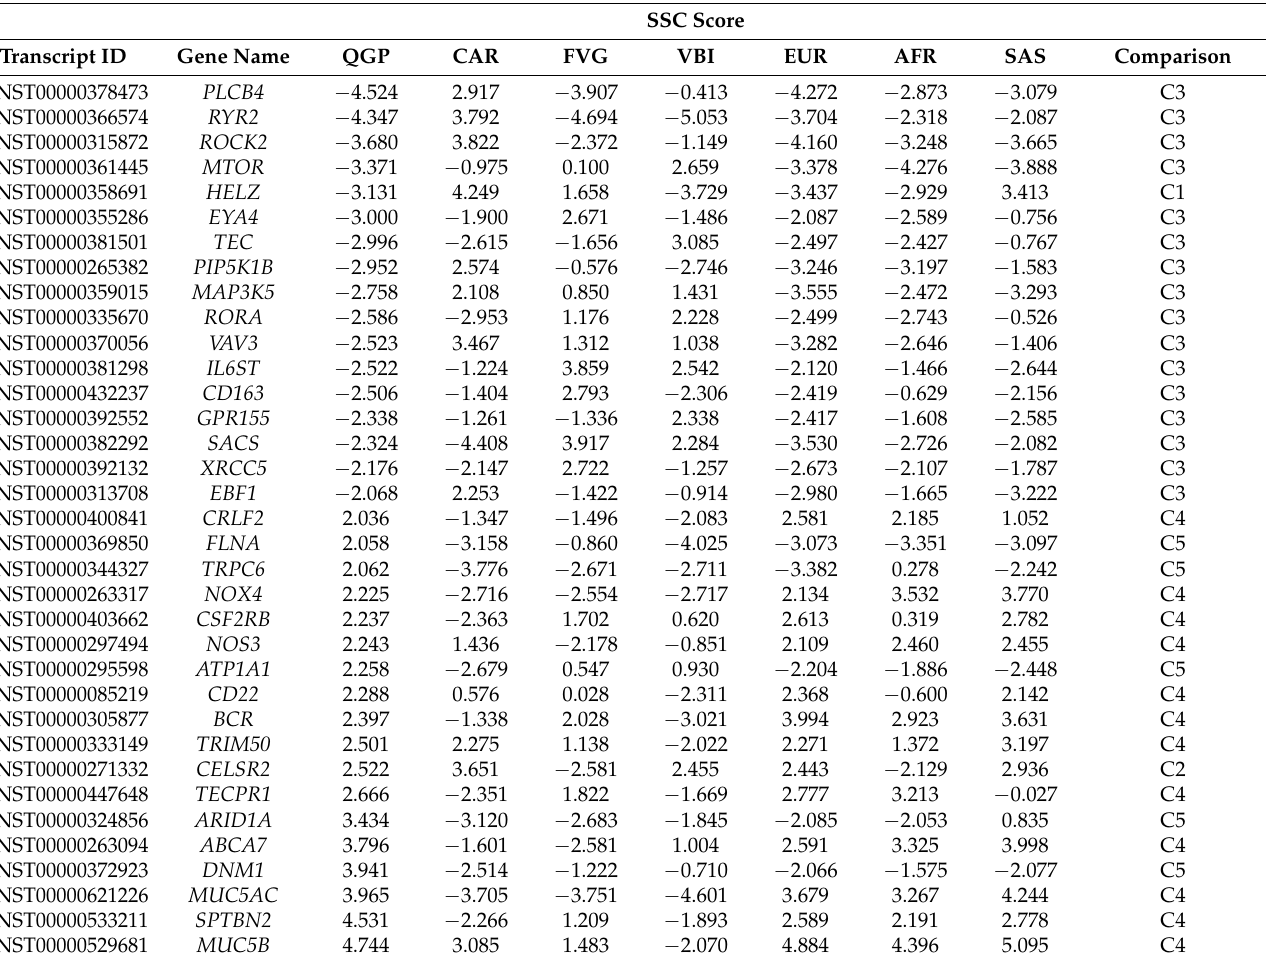
Table 2. Results from comparison of SSC scores between target cohorts (CAR, FVG, VBI, QGP) and the relevant reference superpopulations from the 1000 Genomes Project (EUR, AFR, SAS). The last column refers to the nature of the comparison carried out, as detailed in Supplementary Table